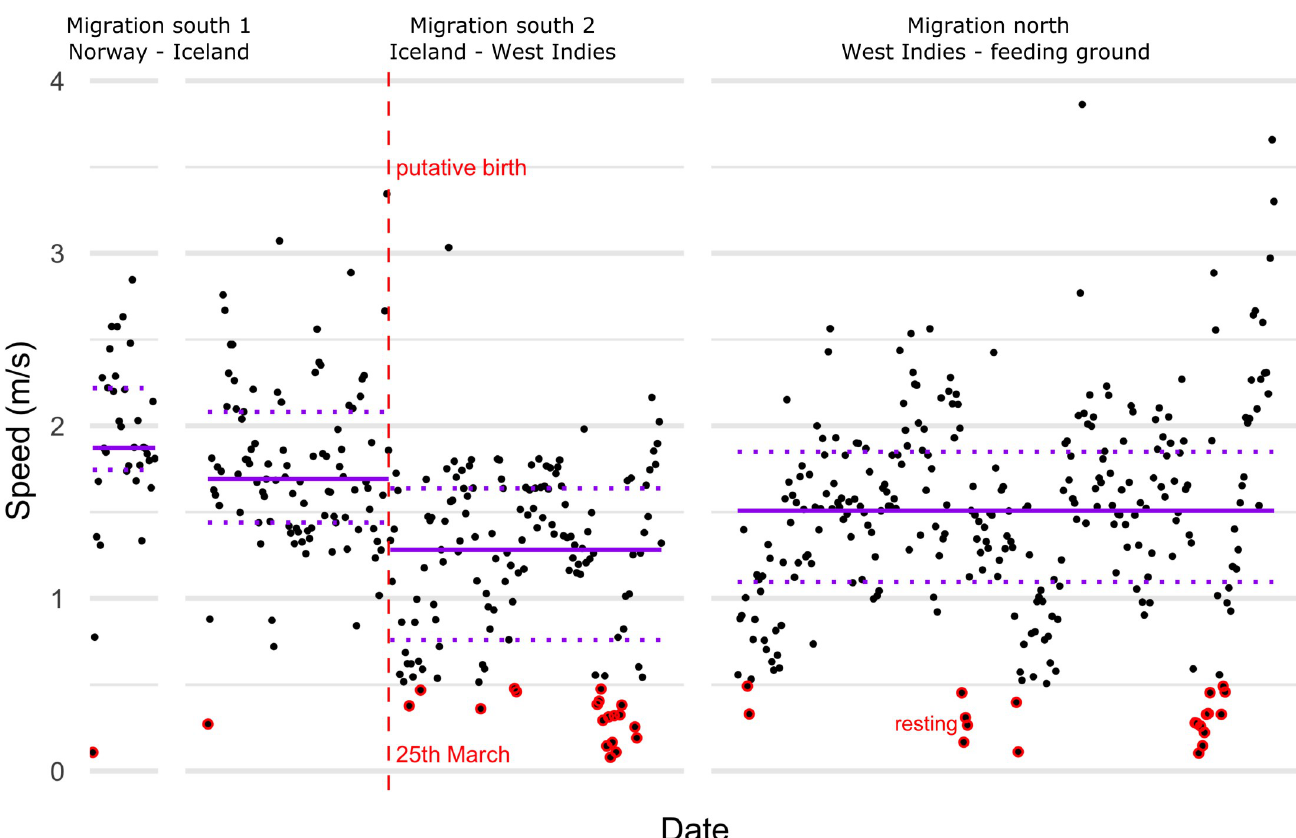
Fig 4. Speed during the migration segments. Chronological from left to right: Norway–Iceland, Iceland–West Indies, West Indies–Barents Sea. Segmentation based on movement persistence. The dotted red line indicates the putative time of calving based on a segmentation analysis of the “southward migration 2” segment, which was associated with a change in median speed from 1.7 ms -1 to 1.3 ms -1 (horizontal lines indicate median speed and dotted lines the respective first and third quartiles).